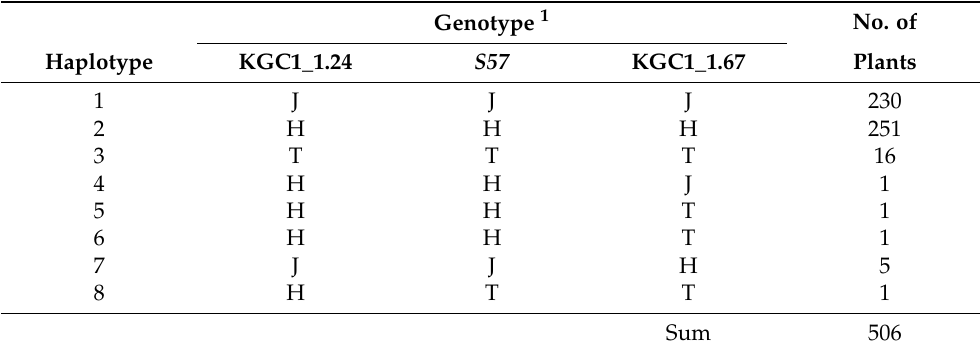
Table 5. Haplotypes around the segregation distortion region on chromosome 1 of BC 5 F 5 using Jpn2 as the donor parent and T65 as the recurrent parent.